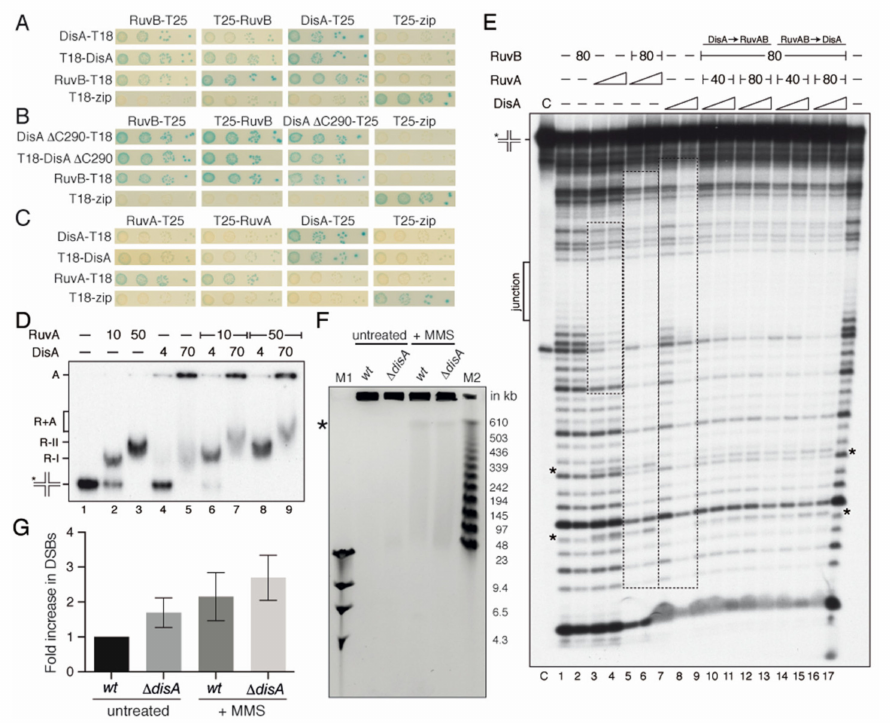
Figure 2. DisA interacts with RuvB and may contribute to fork protection. ( A – C ) Bacterial two-hybrid interaction assays were done, co-transforming the pair of plasmids expressing full-length DisA, DisA ∆ C290, RuvB, or RuvA fused at the N- or C-terminus, to either the T18 or T25 domain of the Bordetella adenylate cyclase. A positive interaction was observed by the appearance of blue color. Experiments were repeated at least 3 times, and representative photographs are shown. In the plates, four serial dilutions of transformed cells were spotted. ( D ) DisA binds RuvA-HJ DNA complexes. [ γ - 32 P] HJ DNA was incubated with the indicated RuvA and/or DisA concentrations for 15 min in buffer C containing 1 mM MgCl 2 at 37 ◦ C. The protein-HJ DNA complexes were separated by 6%